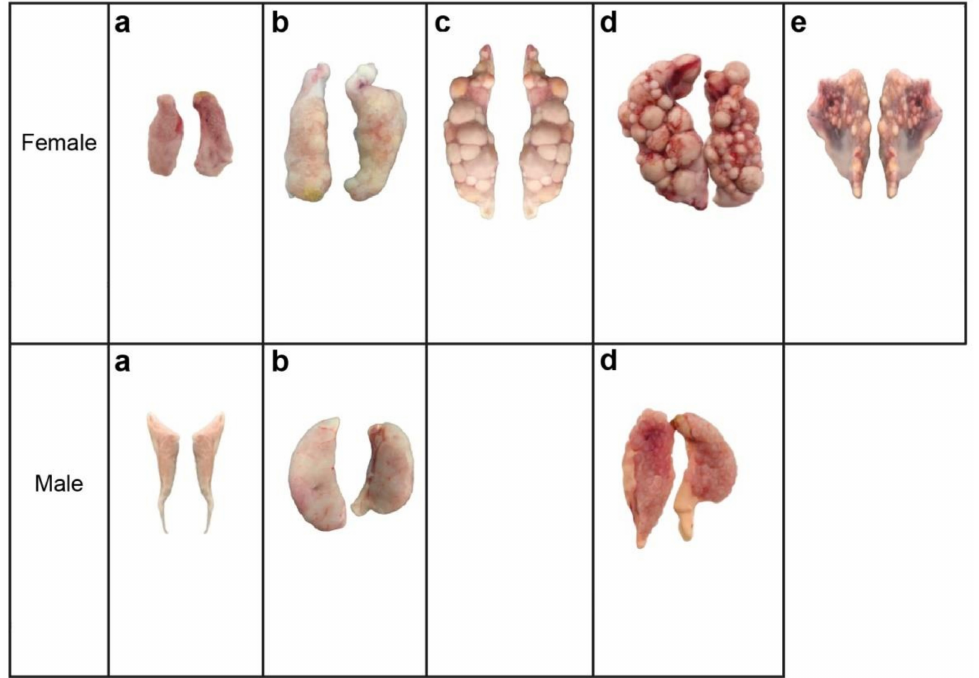
Figure 3. Gonad maturation stages of ocellate spot skate Okamejei kenojei specimens collected from the West Sea of Korea in 2019 and 2020 (Immature— a ; Maturing— b ; Mature— c ; Ripe— d ; Spawning and spent— e